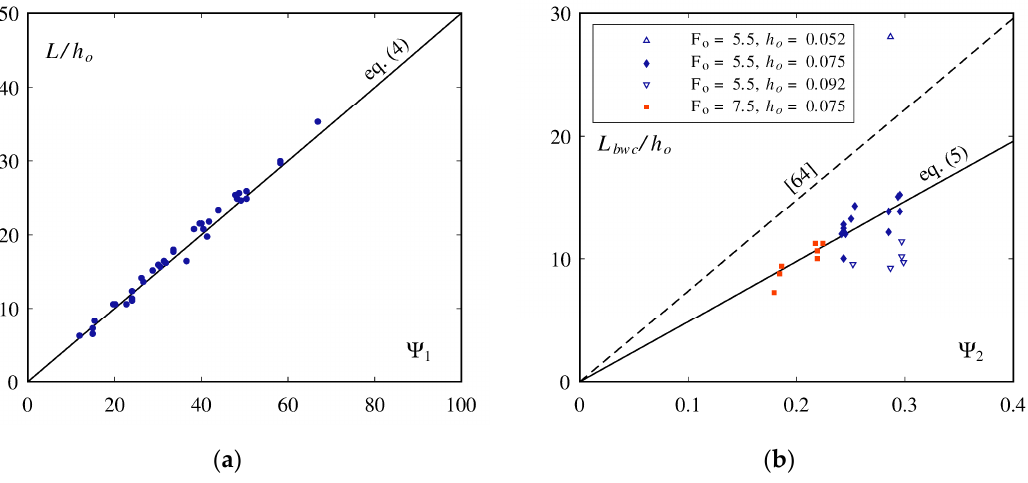
Figure 7. ( a ) Relative jet length L / h o as a function of Ψ 1 = (1 + sin φ ) 2 ·(1 + tan α ) 4 ·F o1.4 ·( t / h o ) 0.4 ; ( b ) Relative blackwater core length L bwc / h o as a function of Ψ 2 = F o − 1 ·(1 + tan α ) − 0.5 ·(1 + sin φ ).